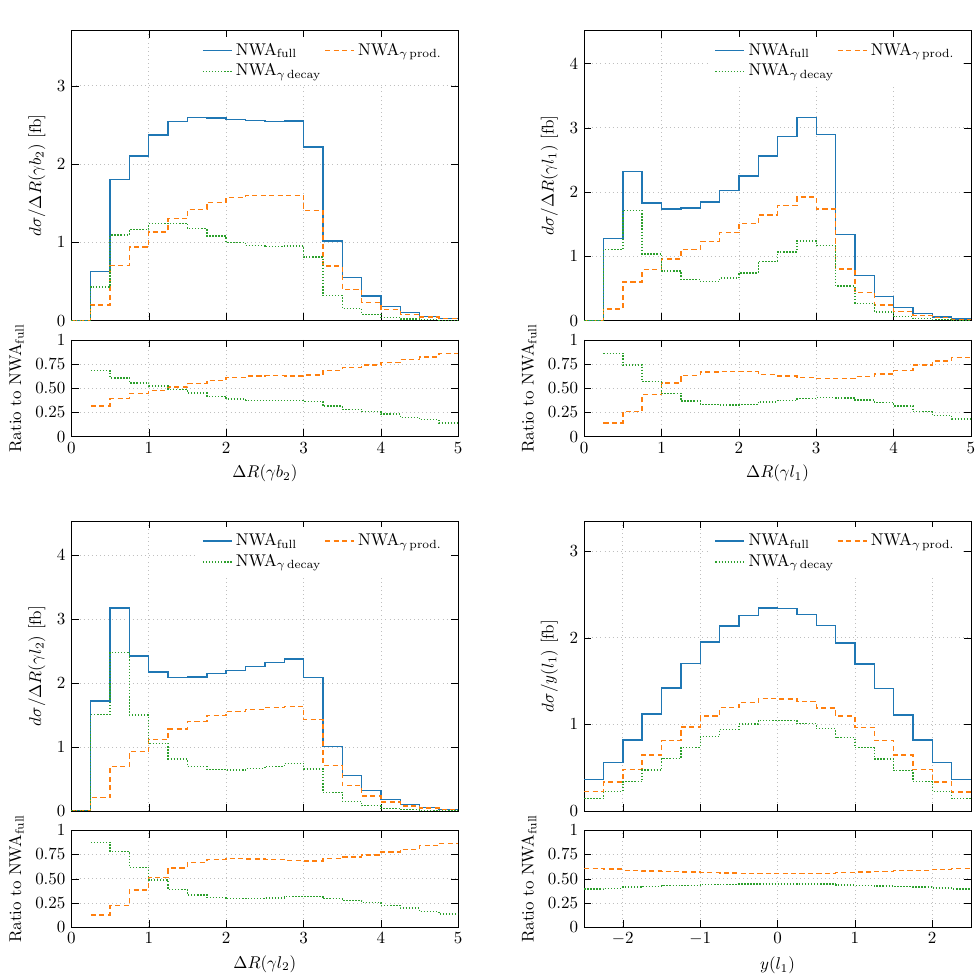
Figure 11 . The pp e + (cid:23) e (cid:22) (cid:0) (cid:22) (cid:23) (cid:22) b (cid:22) b(cid:13) di(cid:11)erential cross section distribution as a function of the ! rapidity-azimuthal angle separation between: the photon and the softer b-jet, (cid:1) R ( (cid:13)b 2 ), the photon and the hardest charged lepton, (cid:1) R ( (cid:13)‘ 1 ), as well as the photon and the softest charged lepton, (cid:1) R ( (cid:13)‘ 2 ) at the LHC run II with p s = 13 TeV. Also shown is the di(cid:11)erential cross section dis- tribution as a function of the rapidity of the hardest charged lepton, y ( ‘ 1 ), The upper plots show absolute NLO QCD predictions in the full NWA together with fraction of events originating from photon radiation in the production, NWA (cid:13) prod , and in decays, NWA (cid:13) decay . The ratios of these contributions to the full NWA result are also shown. Results are given for (cid:22) 0 = H T = 4 and the CT14 PDF sets are employed.